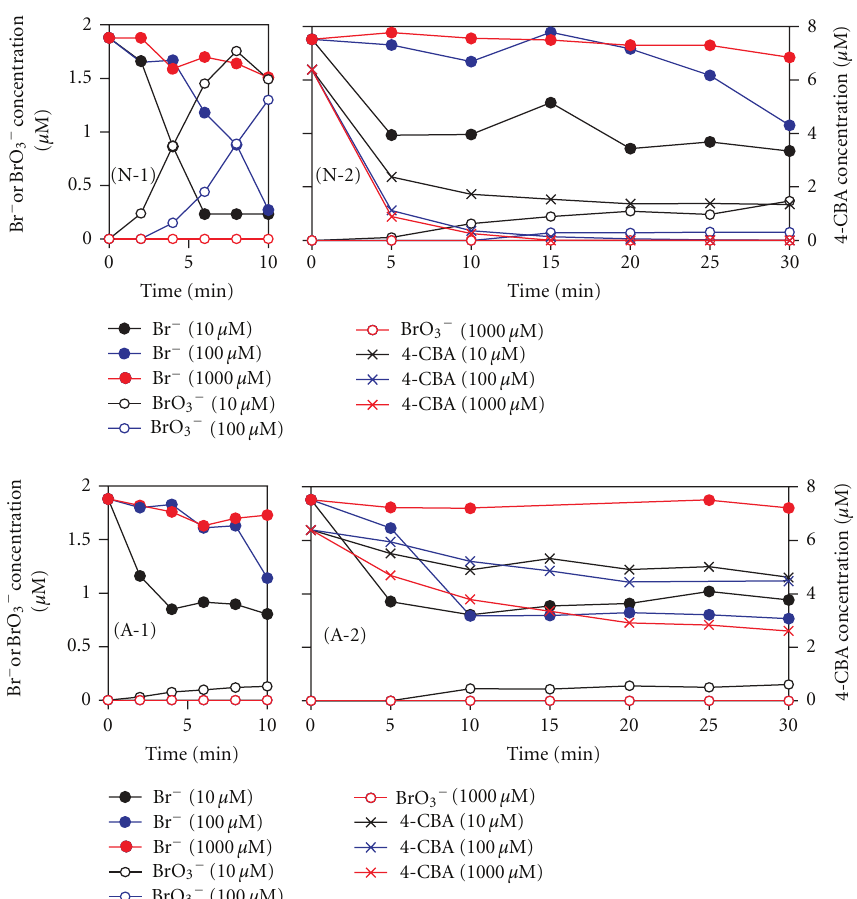
Figure 5: Changes in concentrations of Br − , BrO 3 − , and 4-CBA during O 3 /H 2 O 2 at various H 2 O 2 doses. The concentrations in the legend mean the H 2 O 2 dose. The symbols in the bracket mean O 3 /H 2 O 2 at neutral pH without 4-CBA (N-1), O 3 /H 2 O 2 at neutral pH with 4-CBA (N-2), O 3 /H 2 O 2 at acidic pH without 4-CBA (A-1), and O 3 /H 2 O 2 at acidic pH with 4-CBA